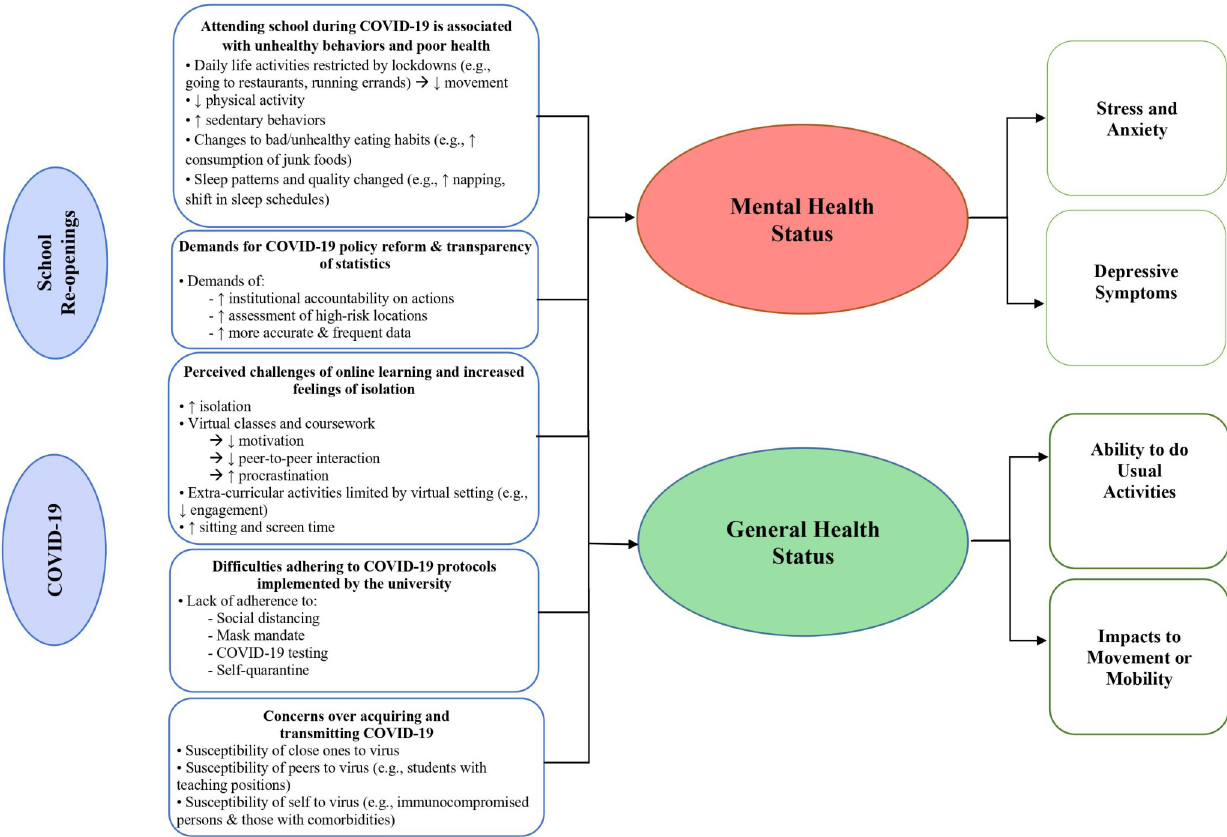
Fig 1. Themes observed from focus group study. The impact of attending university during COVID-19 on student respondents’ mental and general health status.